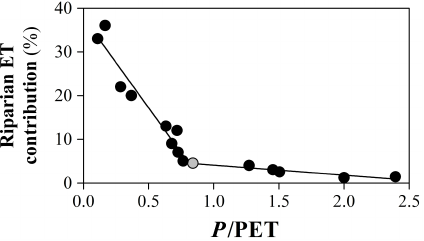
Figure 6. Relationship between the relative contribution of riparian evapotranspiration (ET) to annual catchment water depletion and the ratio between annual precipitation and potential evapotranspi- ration ( P /PET) for a set of catchments worldwide ( n = 15). To- tal water output fluxes from the catchment are stream discharge, catchment evapotranspiration, riparian evapotranspiration, and an- thropogenic extraction (if applies). The Font del Regàs catchment (present study) is indicated with a gray circle. More information and references of the study sites are in the Supplement (Table